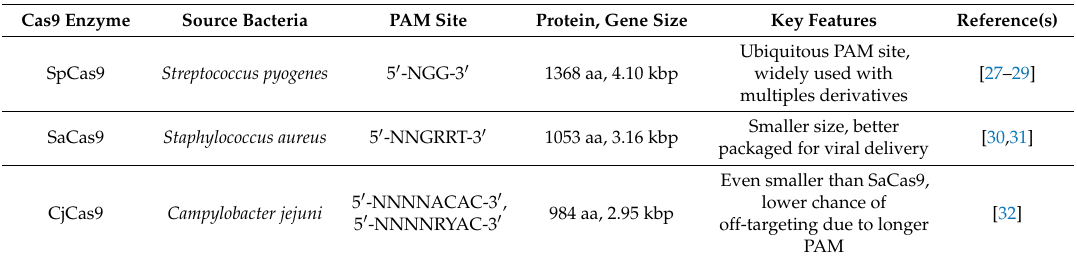
Table 1. Cas9 enzymes used in conjunction with clustered regularly interspaced short palindromic repeats (CRISPR) for Duchenne muscular dystrophy (DMD) treatment. Outlining the three Cas9 nucleases used thus far to reframe the dystrophin gene, and selected features. Cas9 Enzyme Source Bacteria PAM Site Protein, Gene Size Key Features